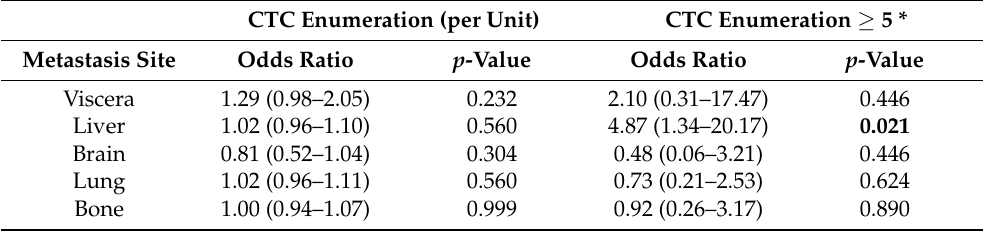
Table 4. Association between circulating tumor cell enumeration and metastasis